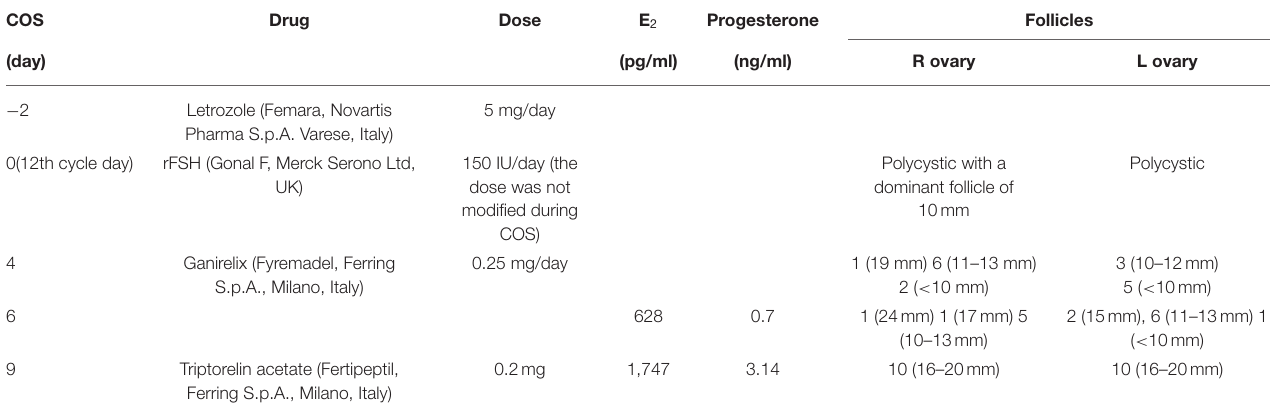
TABLE 2 | Ovarian stimulation protocol. COS Drug Dose E 2